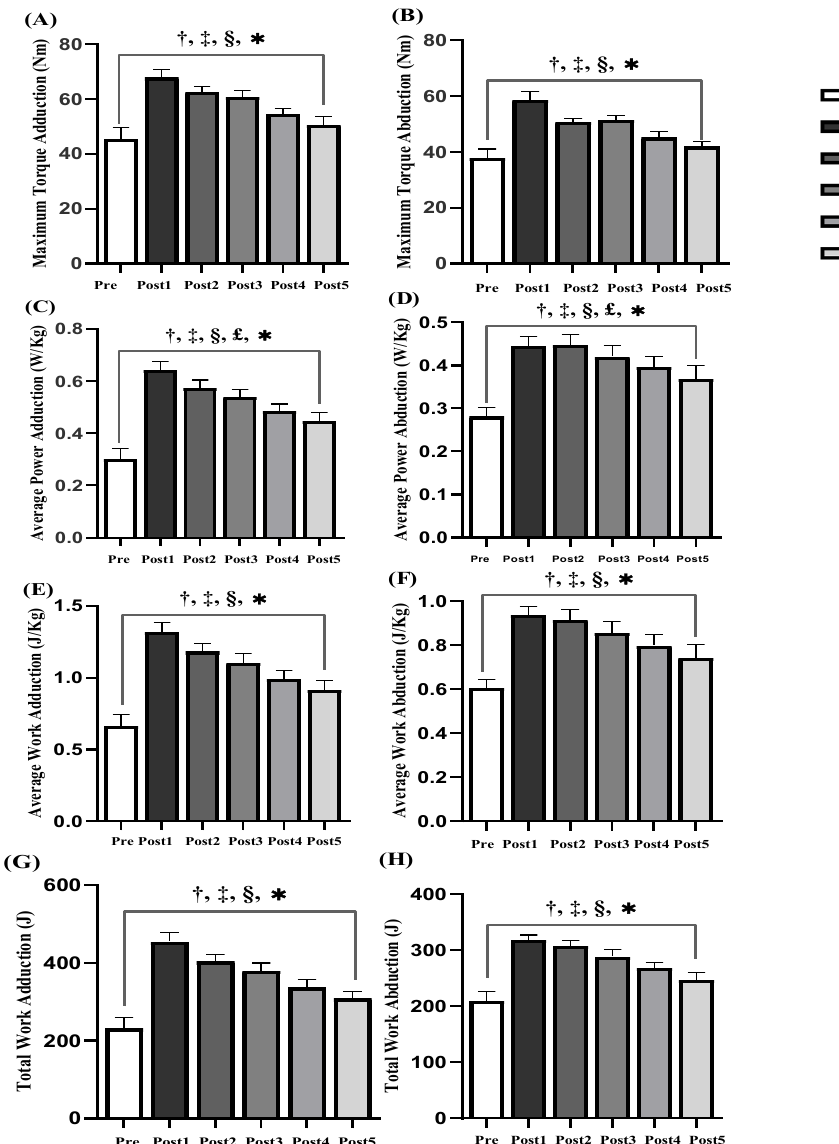
Figure 6. Comparison of adduction/abduction (Add/Abd) motion parameters of shoulder joint before and after acupuncture ( n = 17): ( A ) Maximum Torque of Add, ( B ) Maximum Torque of Abd, ( C ) Average Power of Add, ( D ) Average Power of Abd, ( E ) Average Work of Add, ( F ) Average Work of Abd, ( G ) Total Work of Add, ( H ) Total Work of Abd. Note: *: Significant shoulder joint Add/Abd muscle endurance ( p < 0.05). †: significant from pre and post1 ( p < 0.05). ‡: significant from pre and post 2 ( p < 0.05). §: significant from pre and post3 ( p < 0.05). £: significant from pre and post 4 ( p < 0.05).